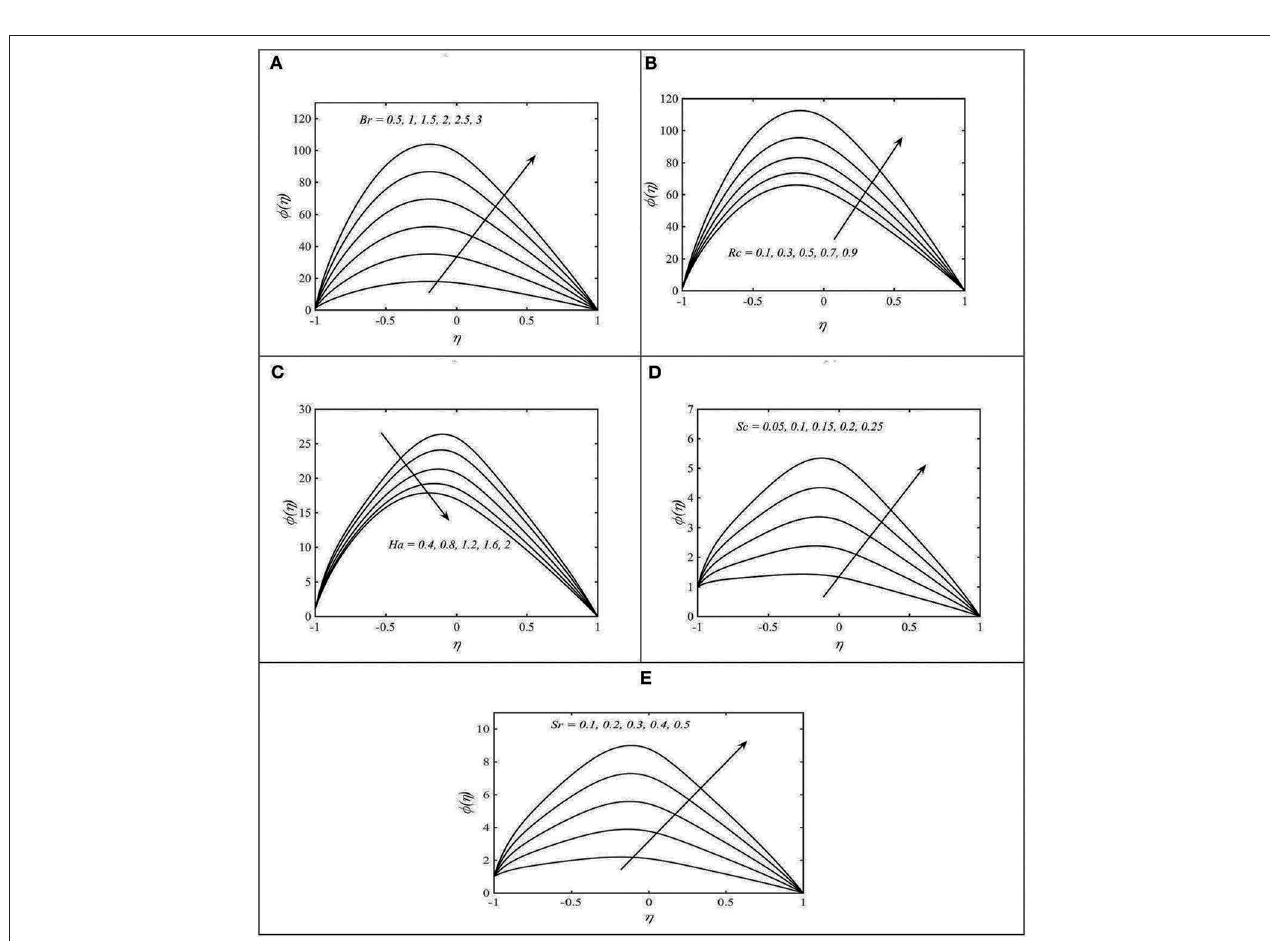
FIGURE 8 | (A–D) Change in ϕ for various values of (A) Br with N 1 = 0.5, N 2 = 1.2, λ = 0.4, and γ = 2; (B) R c with Br = 2, N 1 = 0.5, N 2 = 1.2, λ = 0.4, and γ = 2; (C) Ha with Br = 2, N 1 = 0.5, N 2 = 1.2, λ = 0.4, and γ = 2; (D) Sc with Br = 2, N 1 = 0.5, N 2 = 1.2, λ = 0.4, and γ = 2; and (E) Sr with Br = 2, N 1 = 0.5, N 2 = 1.2, λ = 0.4, and γ =